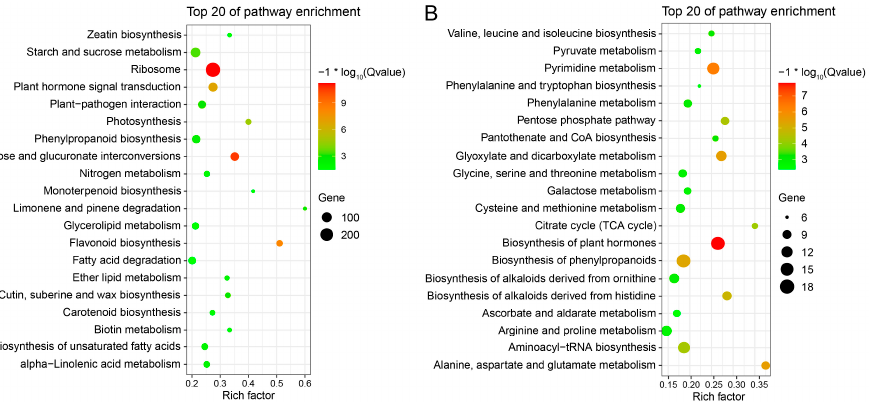
Figure 6. Scatterplot of enriched KEGG pathways for the DEGs ( A ) and differential metabolites ( B ) between Lan3 and 503. Only the top 20 most strongly represented pathways are displayed. The enrichment factor is the ratio of the total number of annotated genes to the DEG number in a certain pathway. The color of the dots represents the range of the − log 10 (Qvalue).